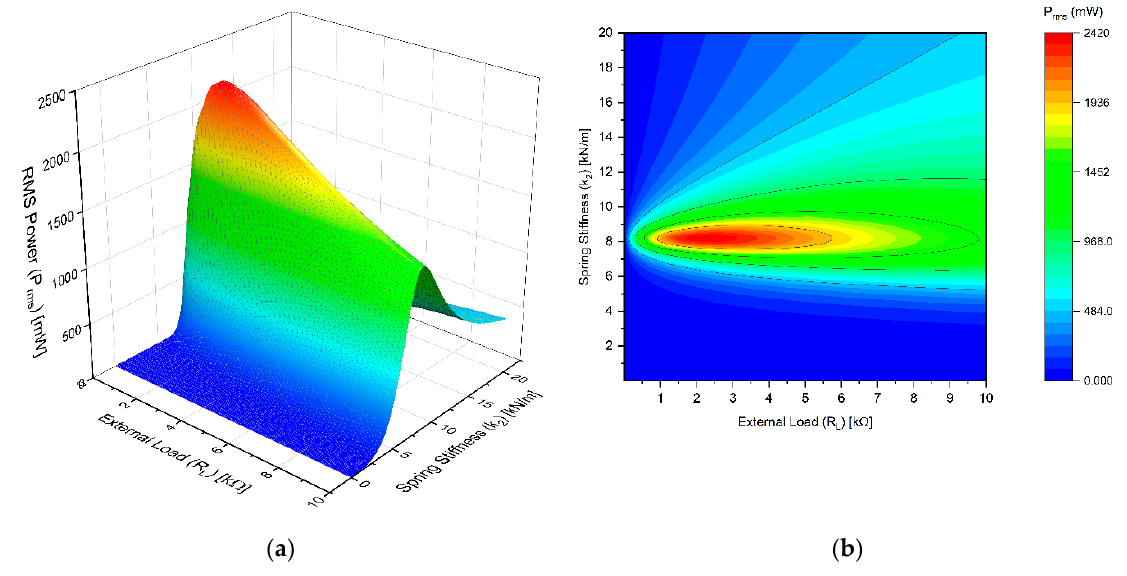
Figure 12. Effect of external load and spring stiffness on the output power of the turbine; ( a ) Rms power of the turbine versus the load and spring stiffness; ( b ) Contour plot of the output power.